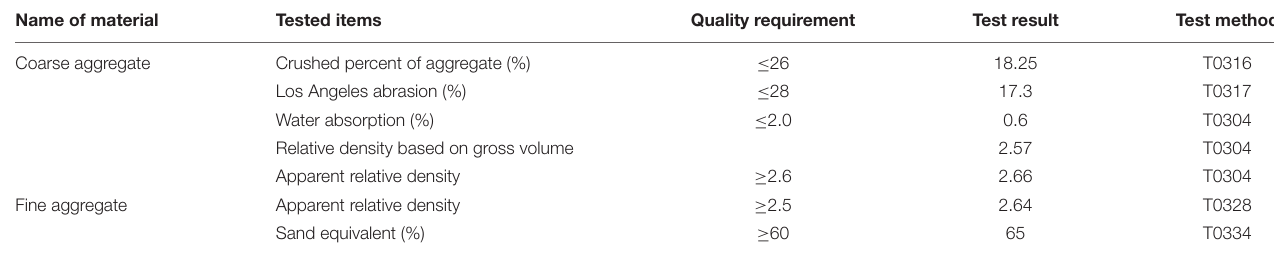
TABLE 2 | Technical indexes of